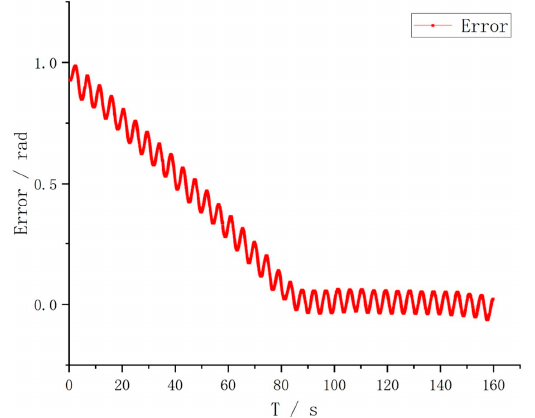
Figure 14. Simulation results of target tracking based on regular gait.